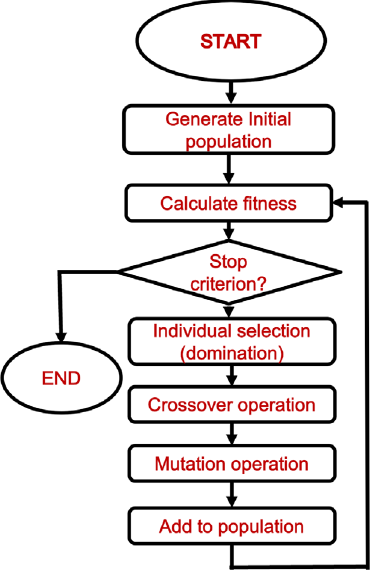
FIG. 4. Generic MOGA flow chart showing how the algorithm progresses, improving the population through successive